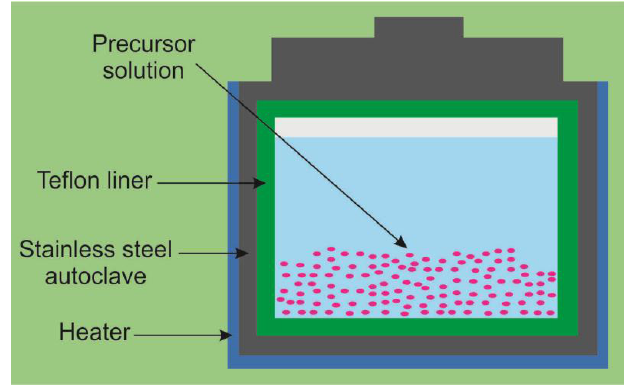
Figure 8. Schematic illustration of a hydrothermal growth system.